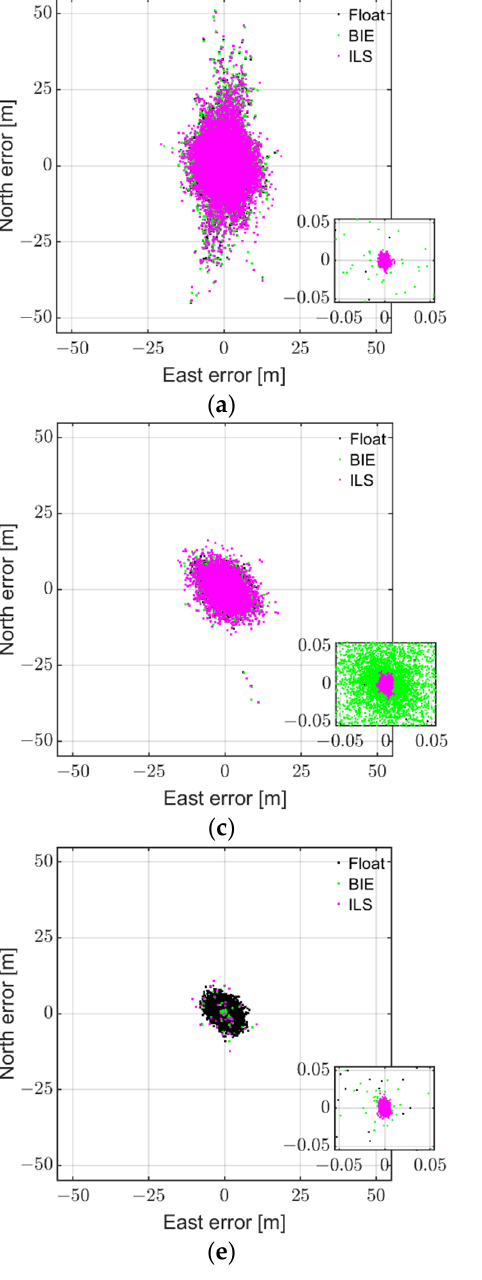
Figure 2. Horizontal (north/east) scatter plot of the multi-GNSS, single-frequency (L1 GPS + E1 Galileo + L1 QZSS + B1 BDS) GP4 data derived with the BIE ( green dots ), ILS ( magenta dots ), and ambiguity float ( black dots ) estimators for instantaneous RTK positioning with external antenna for a short baseline in Dunedin, New Zealand, based on 8 h of data (1 s measurement interval): ( a ) 11.5% ILS SR (38° cut-off); ( b ) 54.9% ILS SR (35° cut-off); ( c ) 79.7% ILS SR (32° cut-off); ( d ) 94.3% ILS SR (30° cut-off); ( e ) 99.8% ILS SR (20° cut-off); ( f ) 99.9% ILS SR (10° cut-off).